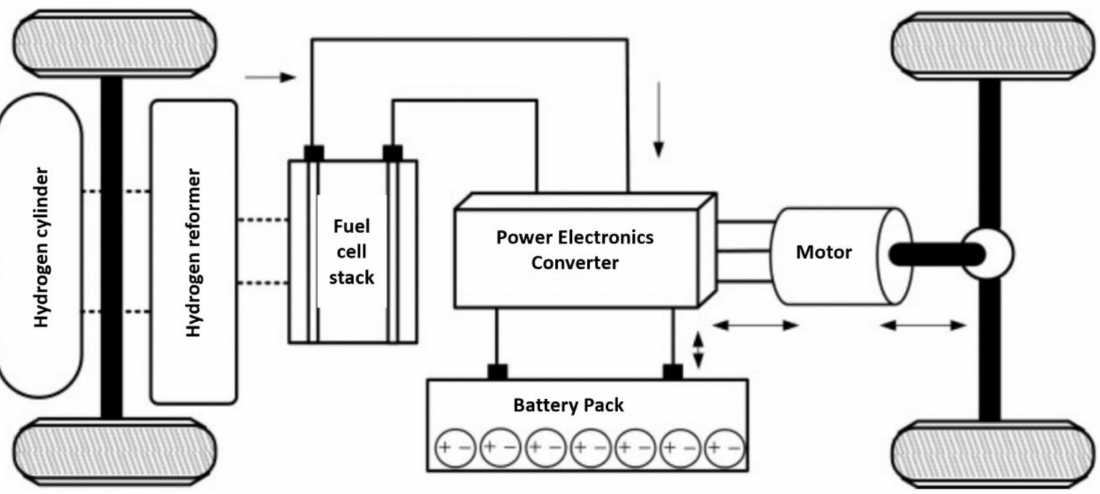
Figure 6. Components of fuel cell electric vehicles